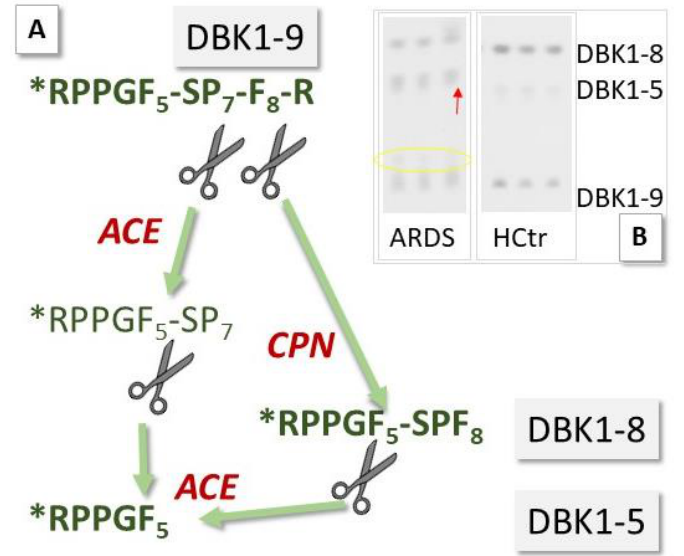
Figure 2. Principle of the neuropeptide reporter assay (NRA) for the study of serum protease activity. A) Bradykinin (BK, sequence: RPPGFSPFR) dabsylated (see star) at the N-terminus (DBK) is degraded in serum by angiotensin-converting enzyme (ACE) and carboxypeptidase N (CPN); fragments DBK1-5 and DBK1-8 serve as readout. B) Exemplary assay data show an increase in the formation of DBK1-5 and a decrease in the formation of DBK1-8 in a 66-year-old, fatally ill ARDS (acute respiratory distress syndrome) COVID-19 patient vs. data from a healthy control (female, 25 years old). The yellow circle indicates the presence of another DBK fragment, which was observed infrequently in the patient cohort and is subject to further study.